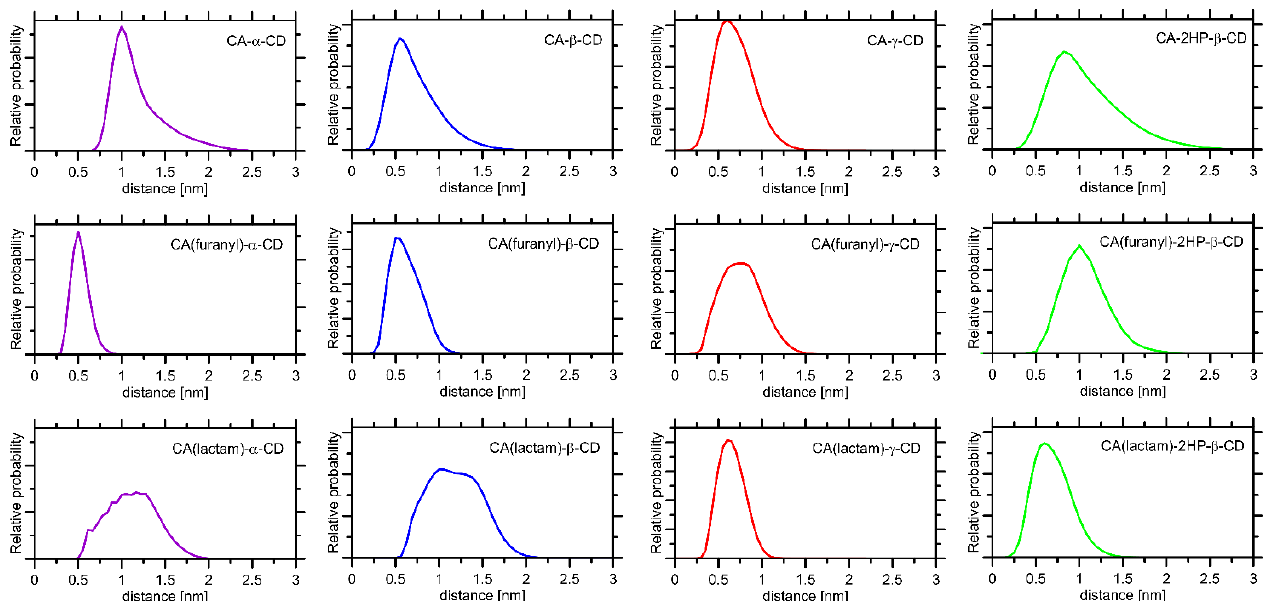
Figure 11. The radial distribution functions (RDFs) calculated from the MD simulations for selected parts of the system. They included pyranose rings of CDs (center-of-mass) and either the whole CA molecule (upper panels) or some of the functional groups present in the CA molecules and identified as significant in CA–CD binding.